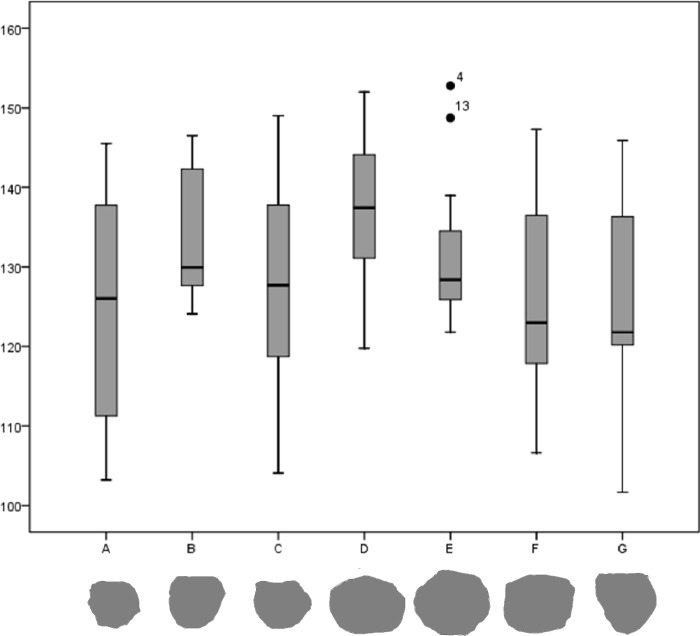
Boxplot underlining the dual tendency of the pieces.Group A (Tools A, C, F and G) compared to Group B (Tools B, D and E).